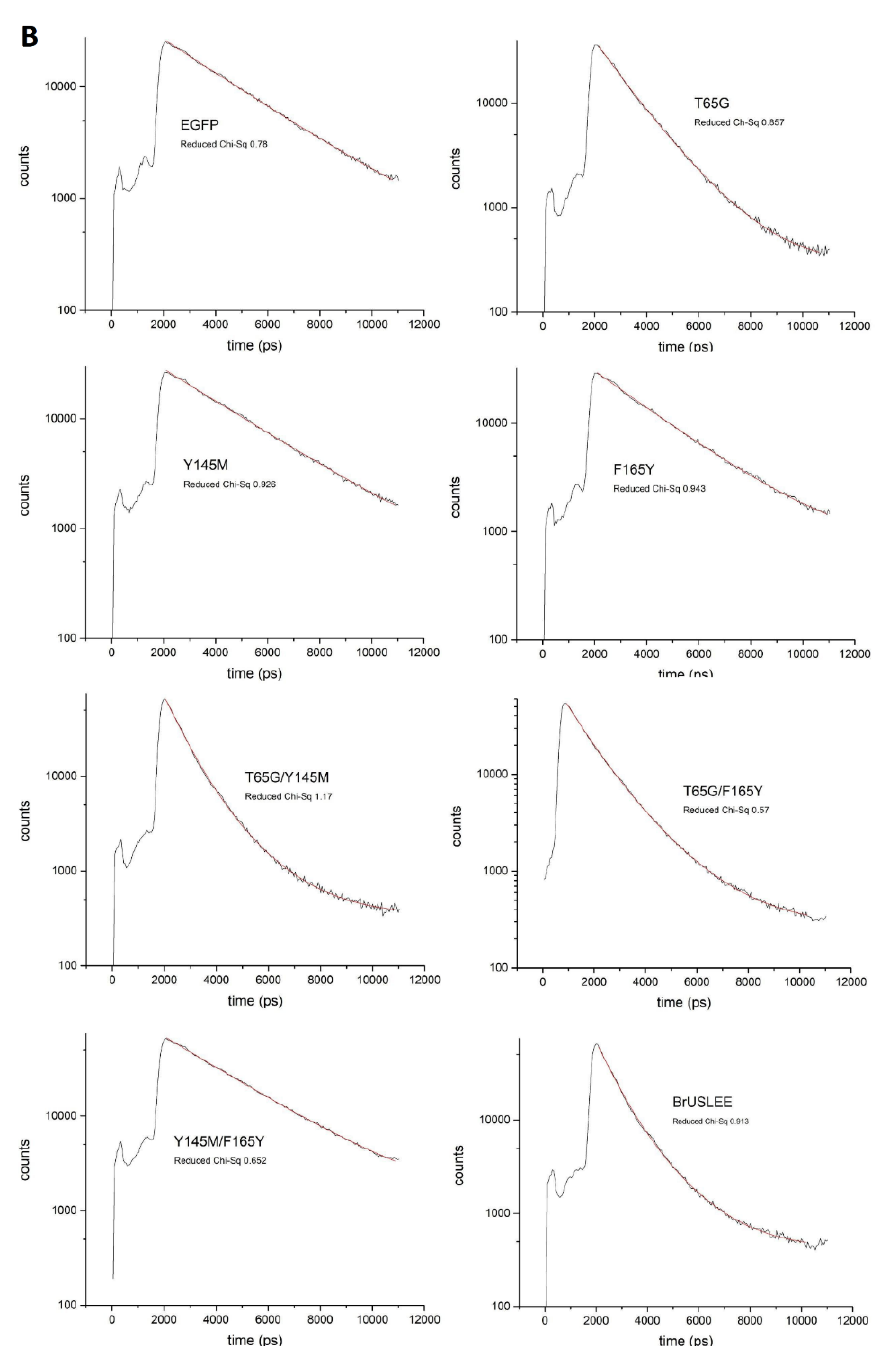
Figure 1. Lifetime measurements in EGFP, BrUSLEE, and the staging mutants. ( A ) A 3D-diagram displaying the lifetime populations found when analyzing fluorescence decays of EGFP; and its mutants at 65, 145, 165 positions, and their combinations. ( B ) Fluorescence decay curves of the purified fluorescent proteins. Experimental decay curves are shown in black, exponential fits are shown in red. Fit accuracy (reduced chi-square) is shown under the name of each protein.